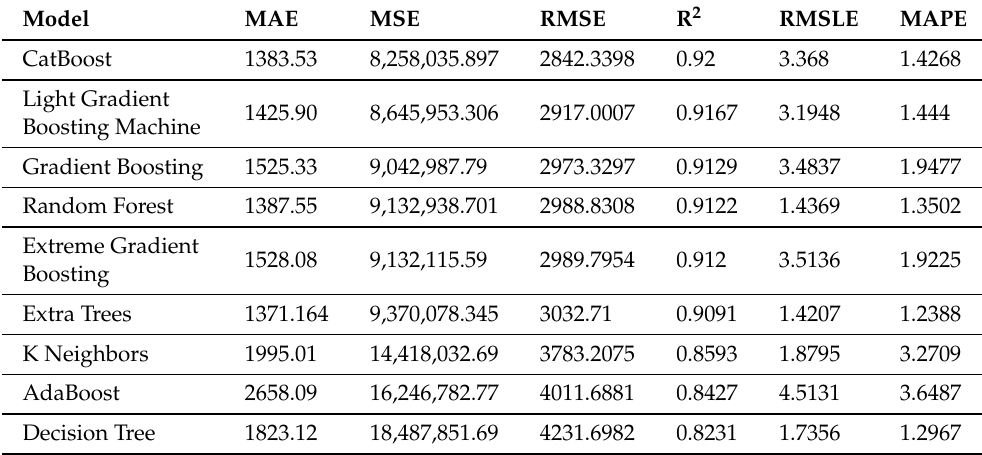
Table 2. Initial study of